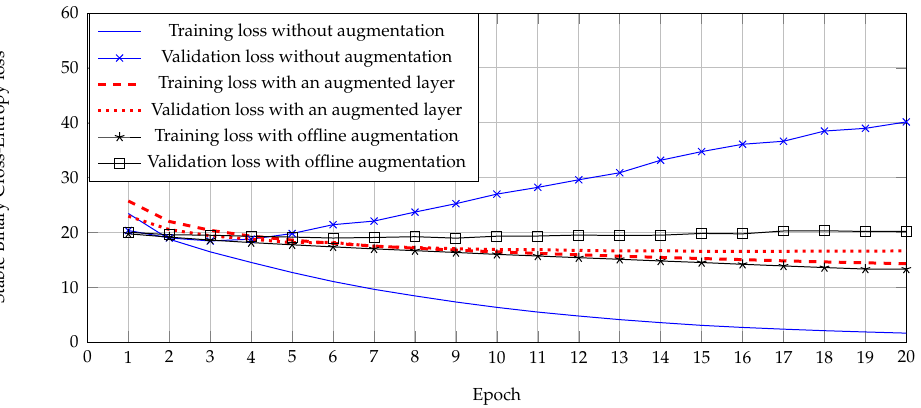
Figure 8. Learning curve between stable binary cross-entropy loss and epoch while training the network from RAPv2.